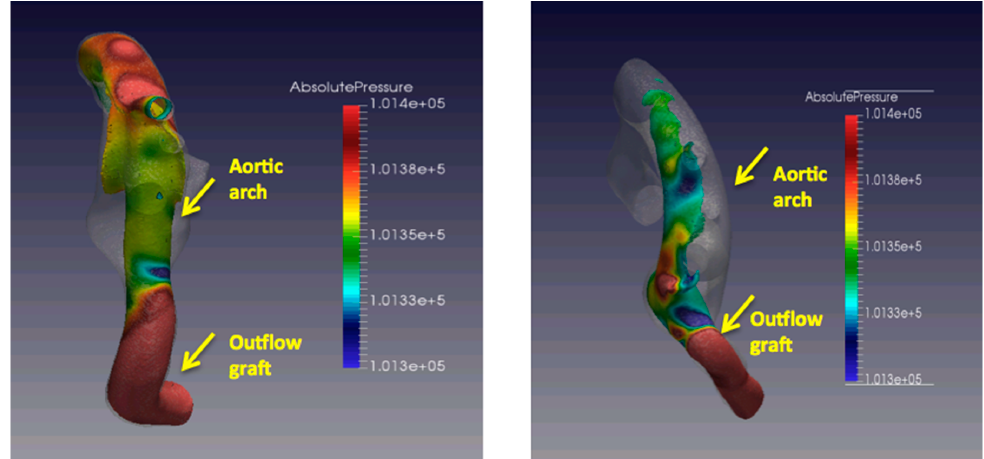
Figure 3. CFD simulations with varying outflow cannula angles relative to the aortic arch and in absolute pressure (in Pascals) and distribution on the aortic arch and great